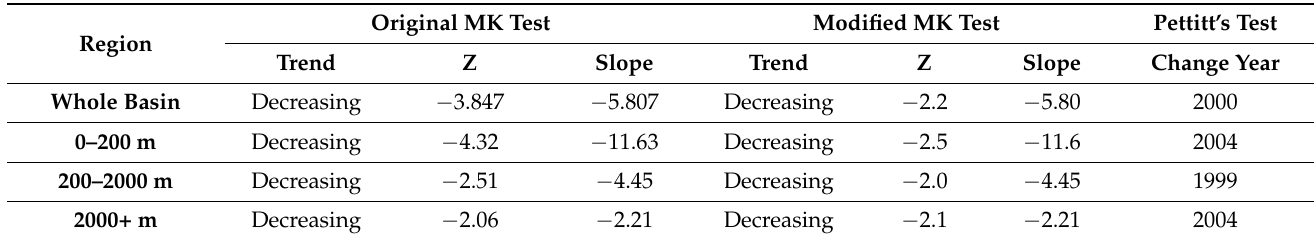
Table 1. Average annual precipitation trends in Ganga–Brahmaputra Basin ( p <